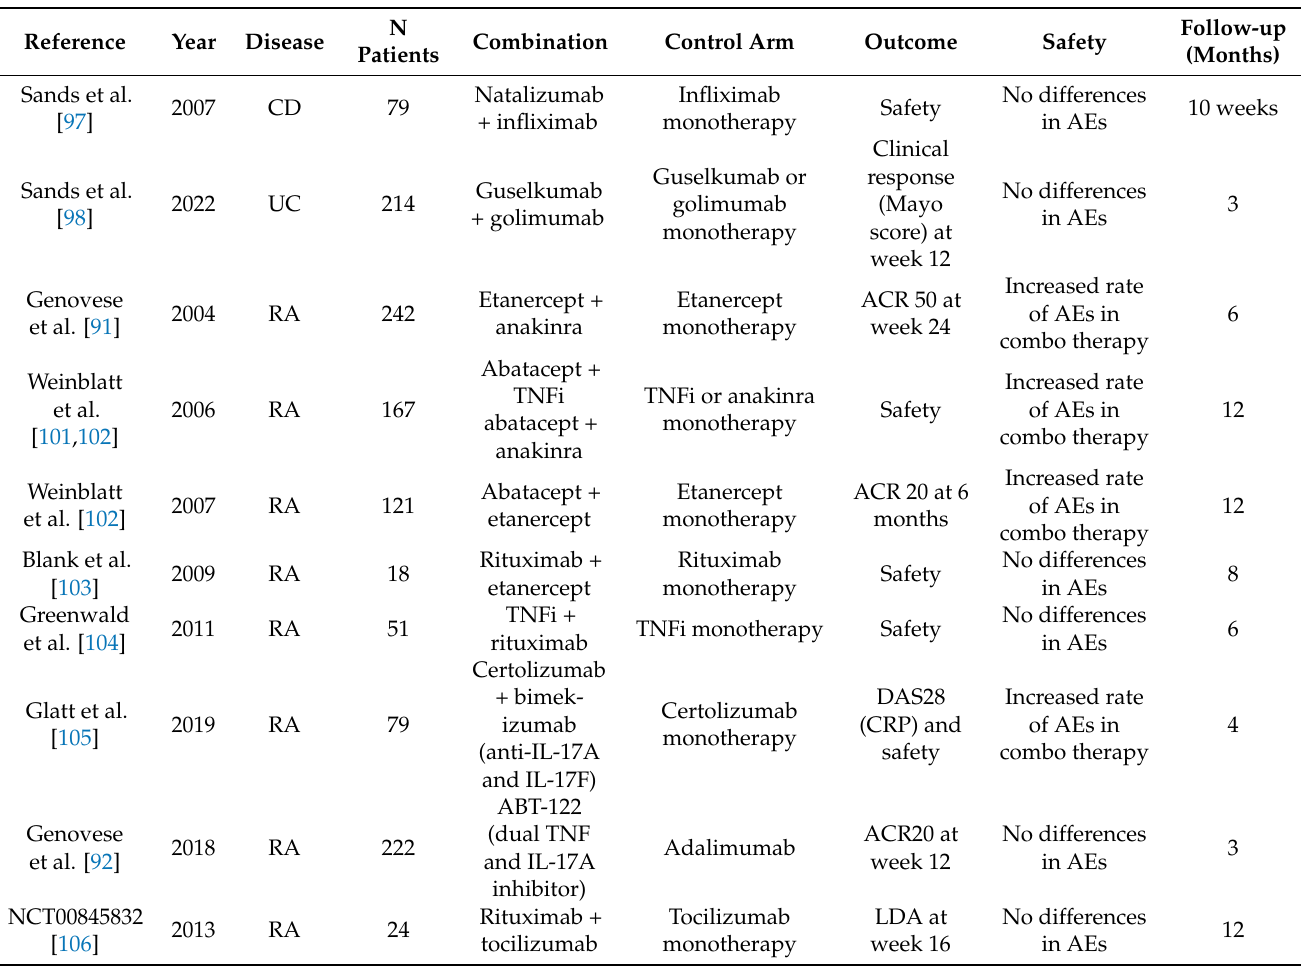
Table 1. Randomized controlled trials on dual targeted therapy in inflammatory bowel diseases and rheumatological immune